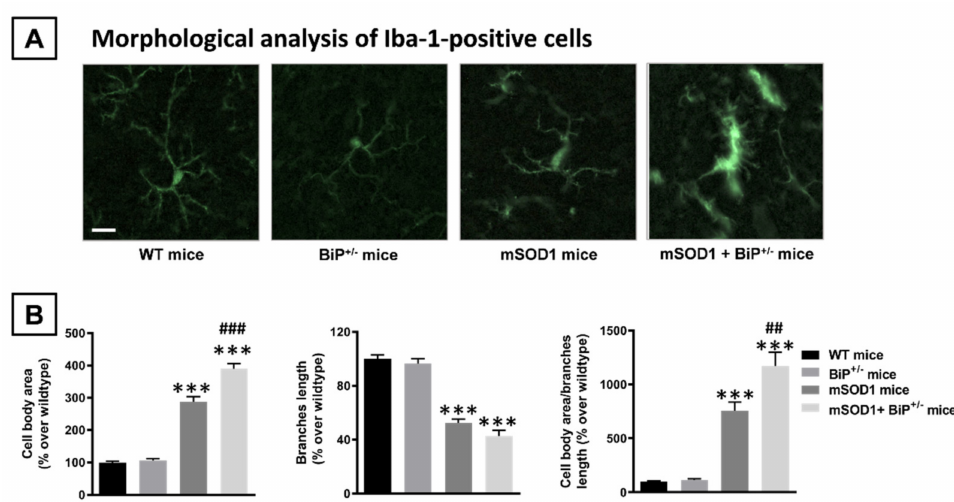
Figure 4. Representative images of Iba-1-positive cells (panel ( A ); scale bar = 25 µ m) detected in the spinal cord (lumbar ventral horn) of mSOD1 transgenic and wild-type male mice with normal or partial ablation of the BiP protein, and their morphological analysis (cell body area, length of branches and their ratio; panel ( B )). Values are means ± SEM of 5–7 animals per group. Data were assessed by one-way analysis of variance followed by the Tukey test (*** p < 0.005 vs. WT and BiP +/ − mice; ## p < 0.01, ### p < 0.005 vs. mSOD1